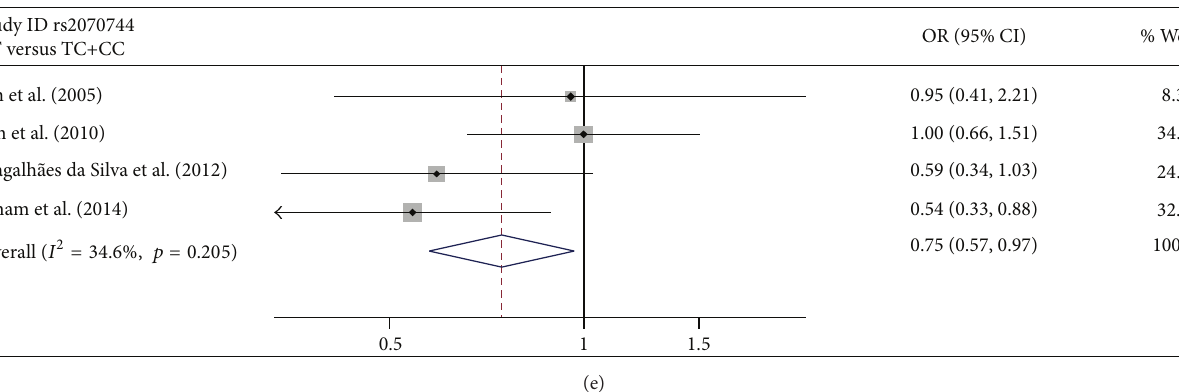
Figure 2: Forest plots of the association of rs2070744 with POAG. Every study was represented by a square whose size was proportional to the weight of the study. Diamond indicated summary odds ratios (ORs) with its corresponding 95% confidence interval (95% CI). (a) Forest plot for rs2070744 and POAG risk in the genetic model of T-allele versus C allele. (b) Forest plot for rs2070744 and POAG risk in the genetic model of TT versus CC. (c) Forest plot for rs2070744 and POAG risk in the genetic model of TC versus CC. (d) Forest plot for rs2070744 and POAG risk in the genetic model of TT + TC versus CC. (e) Forest plot for rs2070744 and POAG risk in the genetic model of TT versus TC +